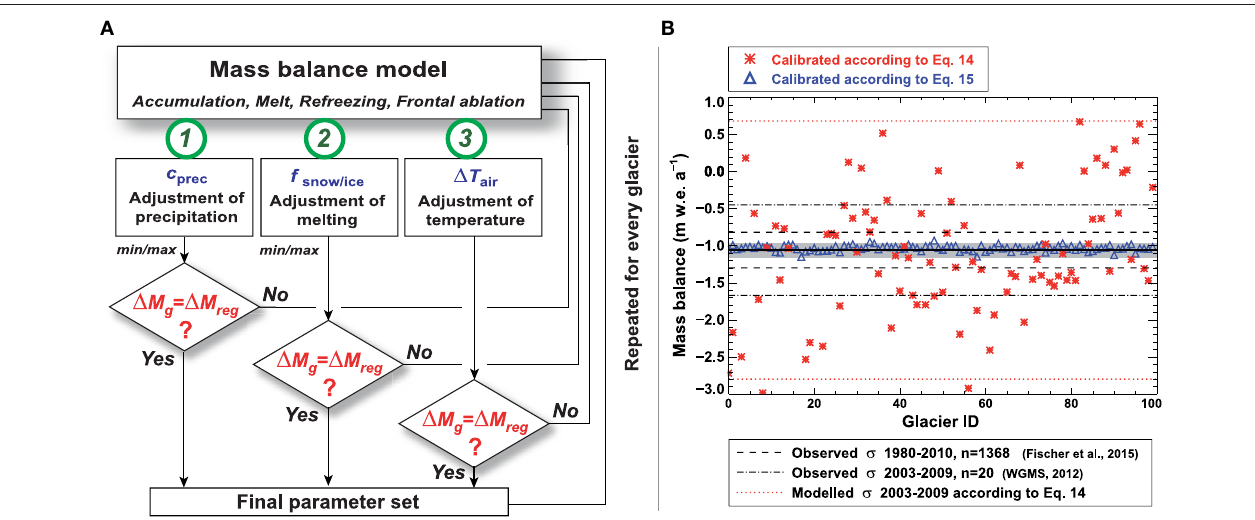
FIGURE 2 | (A) Visualization of the calibration scheme. For each glacier the calibration steps 1, 2, and 3 are passed through sequentially until a final parameter set is found based on Equation (15). (B) Comparison of two possible methods (Equations 14, 15) to calibrate the model. Symbols refer to glacier-wide specific mass balance rates averaged over the period 2003 to 2009 for 100 randomly selected glaciers within the RGI region Central Europe. The solid horizontal line indicates the regional mass balance 1 M reg ± the allowed range (shaded) if Equation (15) is applied. Dashed and dash-dotted lines show observed standard deviations σ of average balance rates of n glaciers from two studies. Both methods yield nearly identical 1 M reg but balance rates for the same glaciers differ strongly between the two calibration methods.